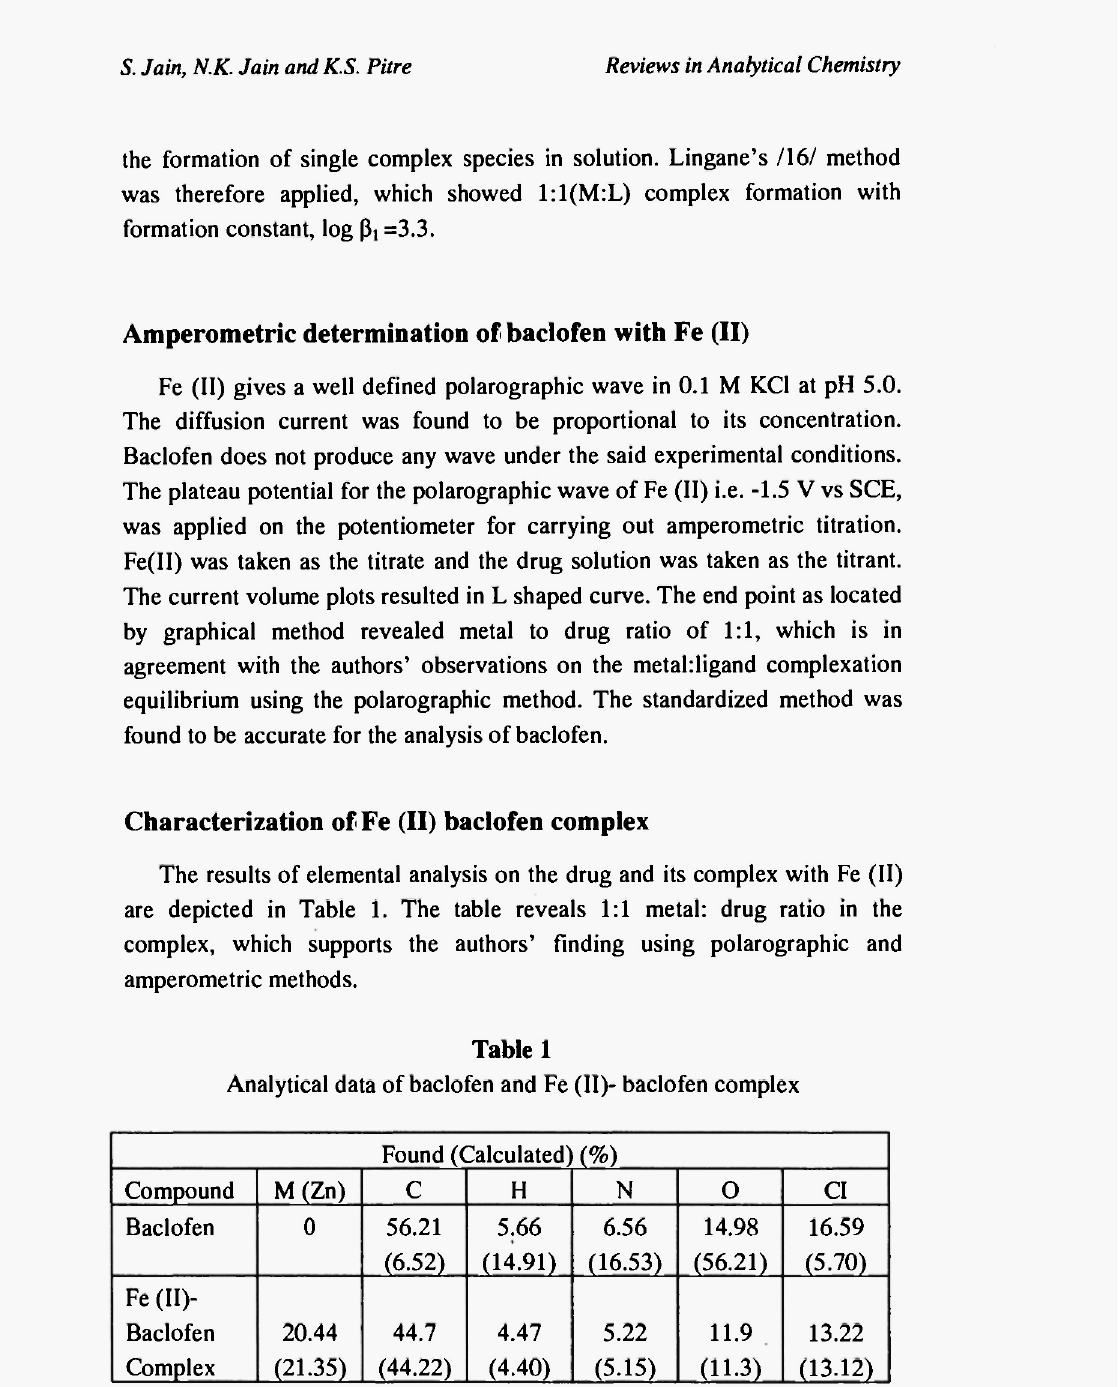
Analytical data of baclofen and Fe (II)- baclofen